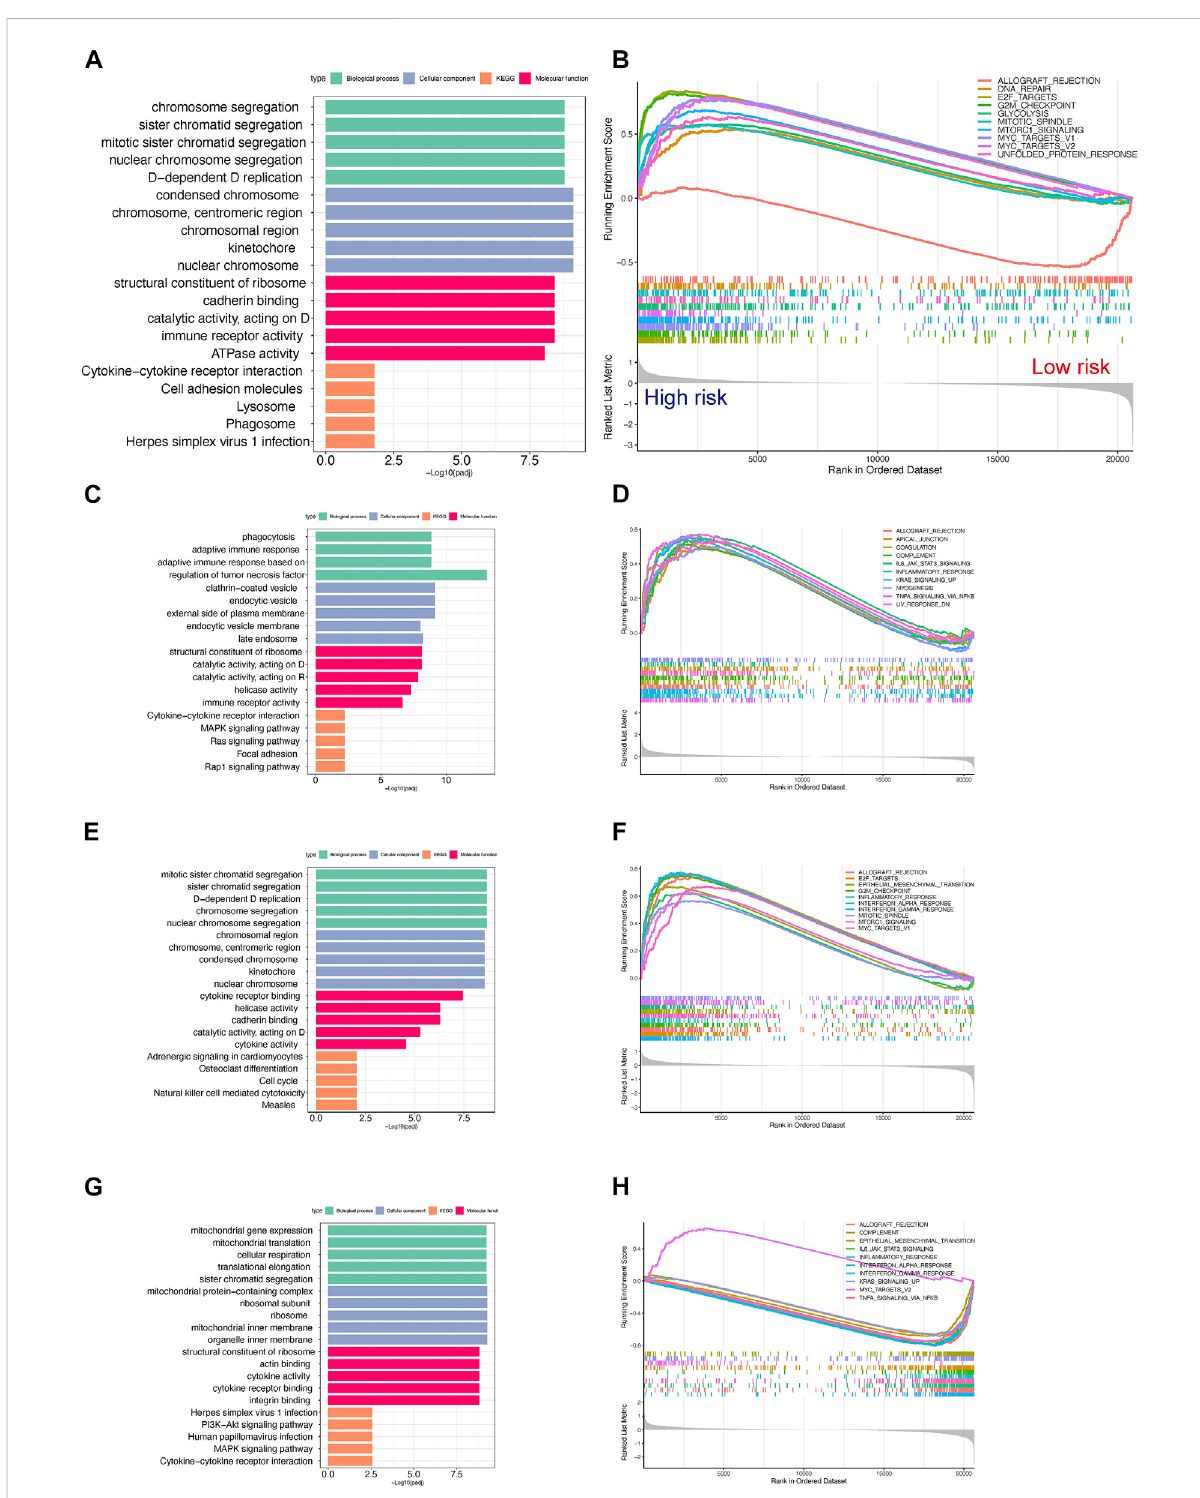
FIGURE 9 Gene set enrichment analysis for high- and low-risk scores in the TCGA-LUAD cohort. (A,B) Top 5 GO and KEGG enriched gene pathway- related catalogs (A) and top 10 GSEA (B) of tumor-related items between high- and low-risk scores in TCGA-LUAD (C,D) . Cluster 1 in GO/KEGG analysis (C) and GSEA (D) results in theTCGA-LUAD cohort ( n = 207) (E,F) . Cluster 2in GO/KEGG analysis (E) and GSEA (F) results in theTCGA-LUAD cohort ( n = 137). (G,H) Cluster 3 in GO/KEGG analysis (G) and GSEA (H) results in the TCGA-LUAD cohort ( n =